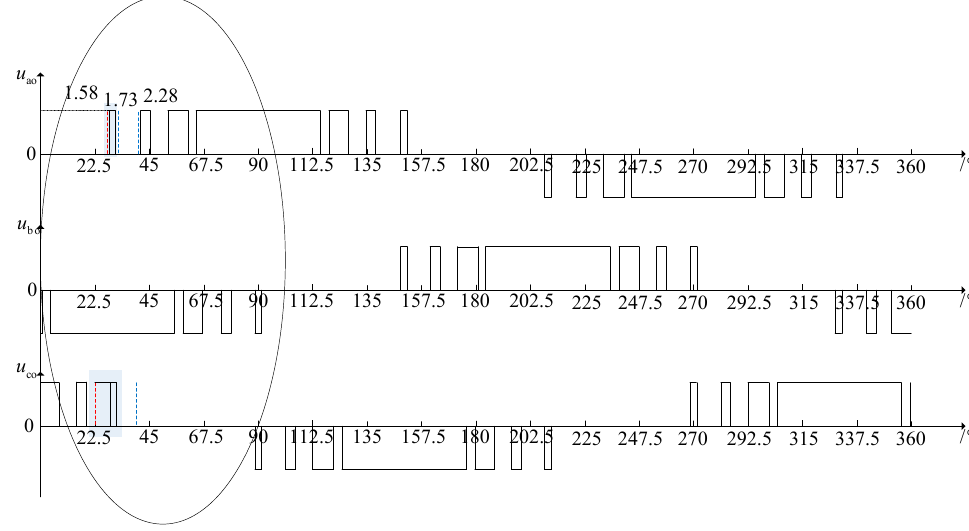
Figure 8. Regulated switching angles with SHEPWM.